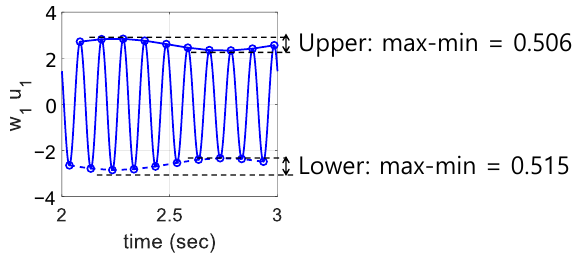
Figure 10. Pattern variations for the modulated control signal. The results are summarized in Table 2, and the difference (C = |A − B|) and the ratios (D = A/B) are compared. The pattern variations of a faulty motor are greater than that of a healthy motor (C > 0 or D > 1). Both indicators (C, D) work well for all cases. For the zero output and fixed output fault modes, the values (C, D) are much greater than the values of the normal case. This means that the greater the pattern variations are, the more severe the fault levels are. For the zero output mode, the healthy motor’s pattern variation ( w 2 u 2 ) is smaller than in the normal case. For the fixed output mode, the modulated control signals are biased because of u 1 , u 2 , and the average of U and L is the proper index. For the scaled-down mode, the pattern variations depend on the degree of